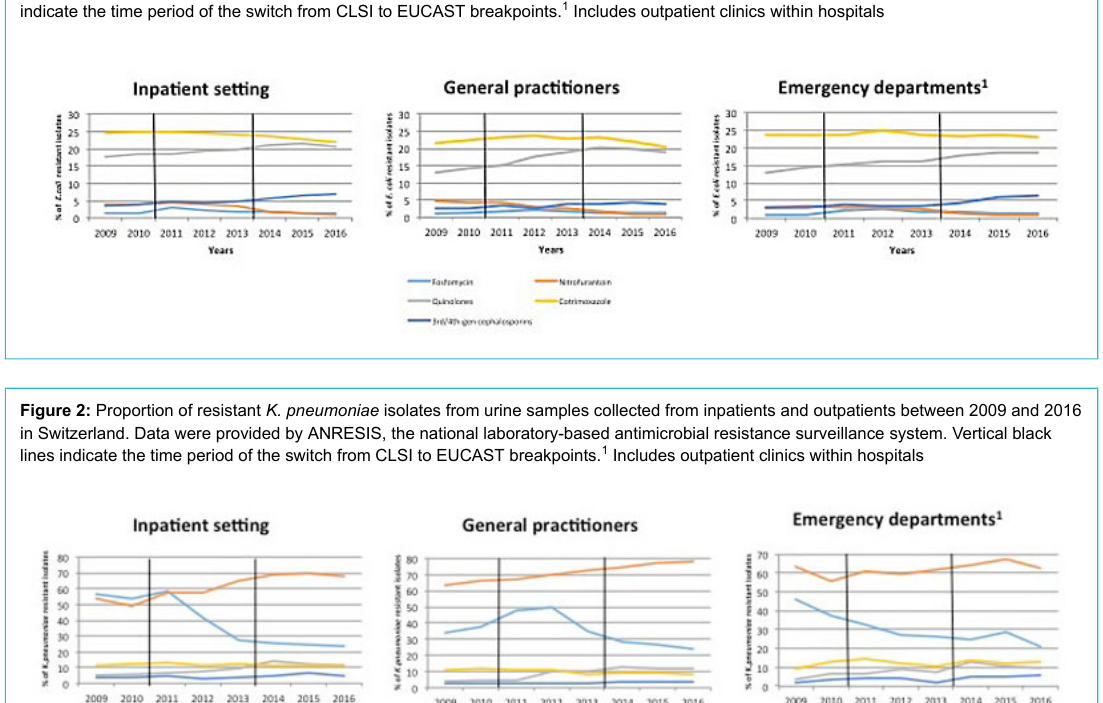
Figure 1: Proportion of resistant E. coli isolates from urine samples collected from inpatients and outpatients between 2009 and 2016 in Switzerland. Data were provided by ANRESIS, the national laboratory-based antimicrobial resistance surveillance system. Vertical black lines indicate the time period of the switch from CLSI to EUCAST breakpoints. 1 Includes outpatient clinics within hospitals